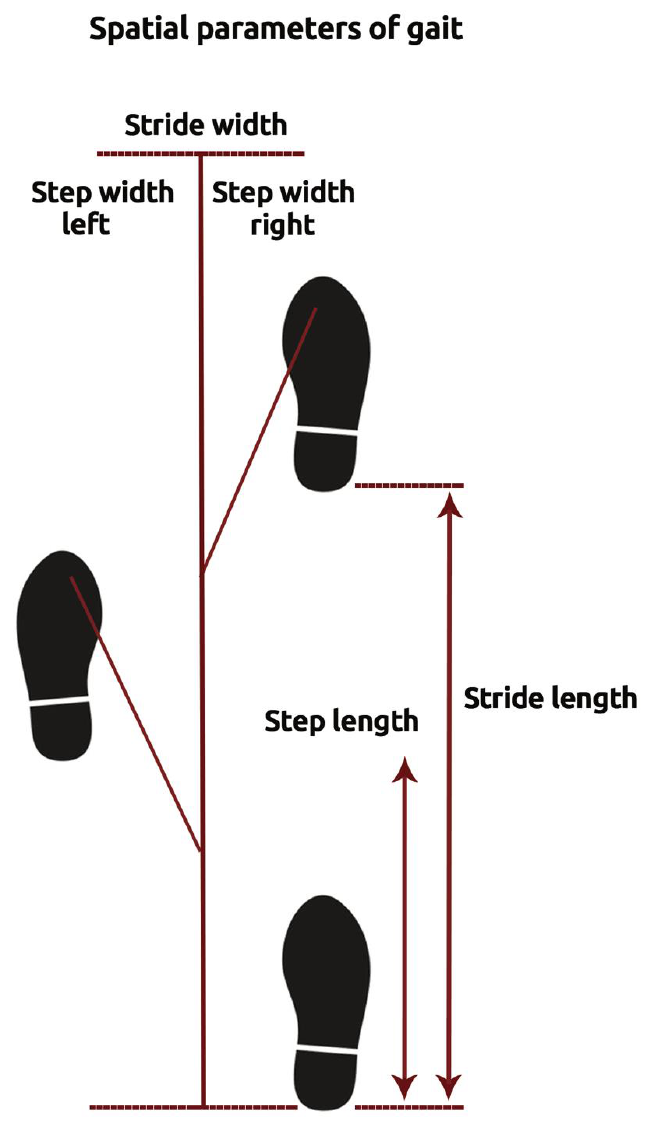
Figure 1. Illustration of spatial parameters of gait.